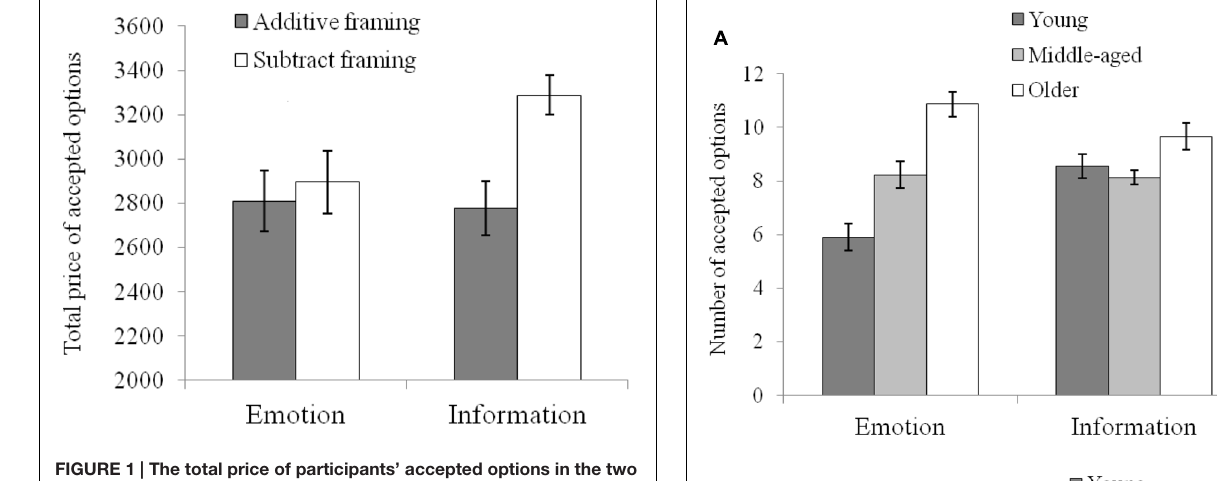
FIGURE 1 | The total price of participants’ accepted options in the two framing conditions.